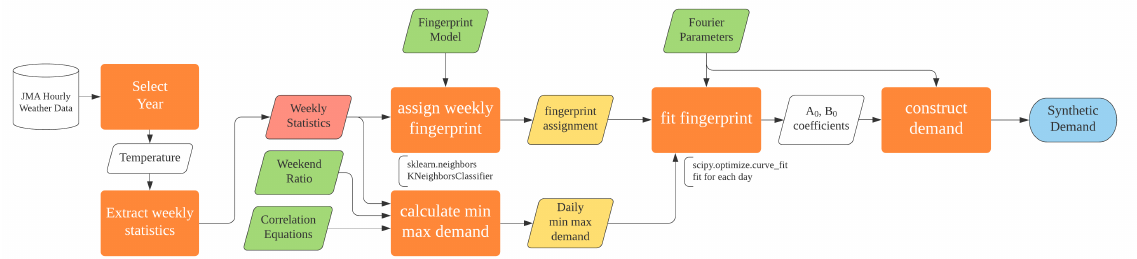
Figure 6. Temperature-dependent demand